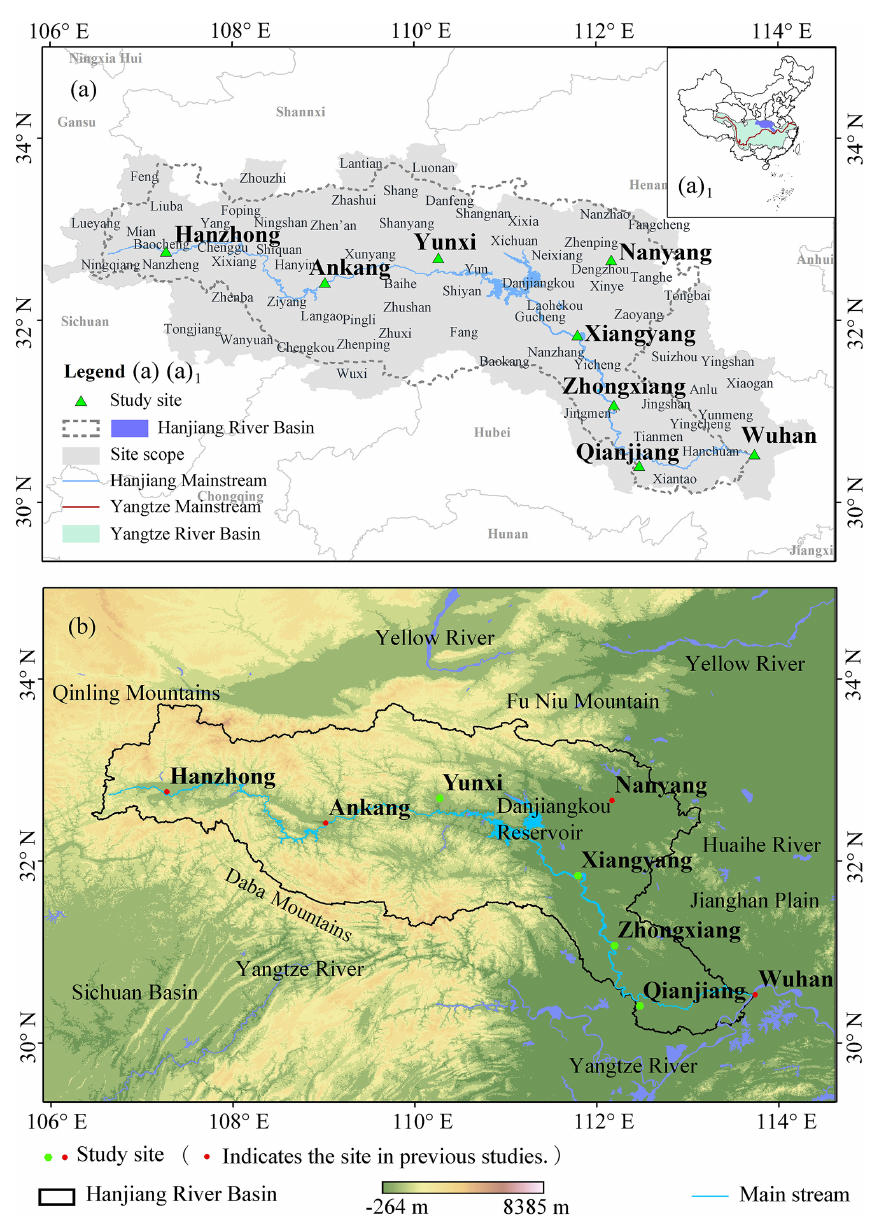
Figure 1. Study area and locations of the eight prefecture capitals used for reconstruction of droughts and floods (a, a 1 , b) . The green points in (b) represent the sites first reconstructed in this study, and study sites in previous work (Central Meteorological Bureau, 1981) are marked as red points in (b) . The inset (a 1 ) in (a) indicates the relative location of the study area in